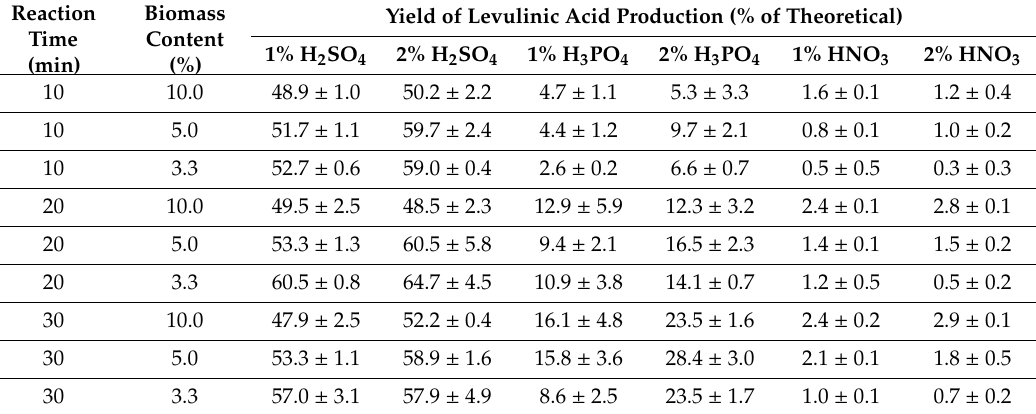
Table 2. Influence of reaction time, biomass content, concentration and type of inorganic acid on yield of levulinic acid production (based on cellulose content in raw material) from pine chips.